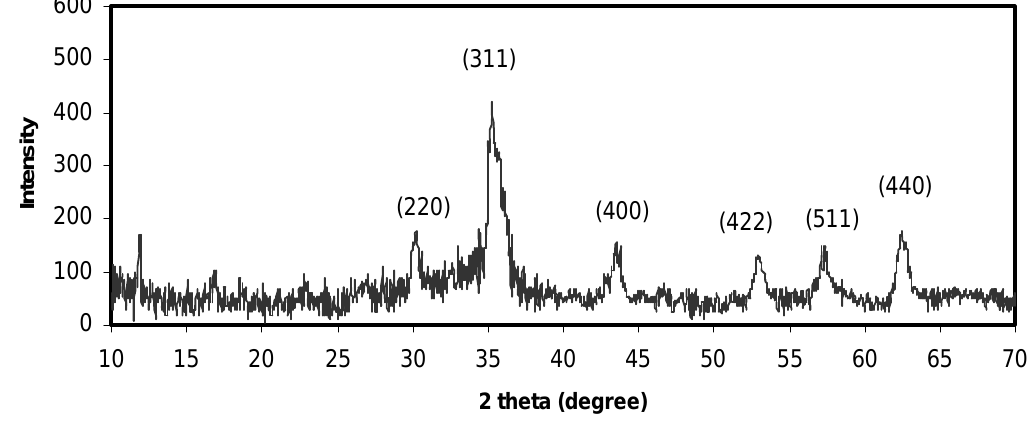
Figure 1. The X-ray diffraction pattern of a sample of Fe diffraction pattern is confirmed from the hkl indices